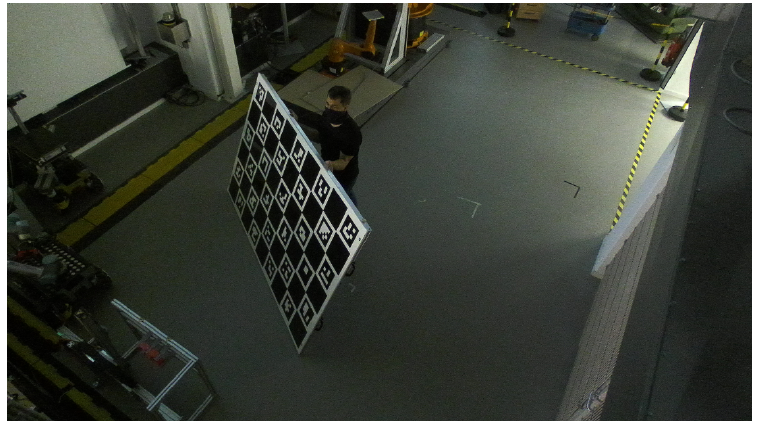
Figure 2. Cumbersome calibration board used to achieve high accuracy calibration.